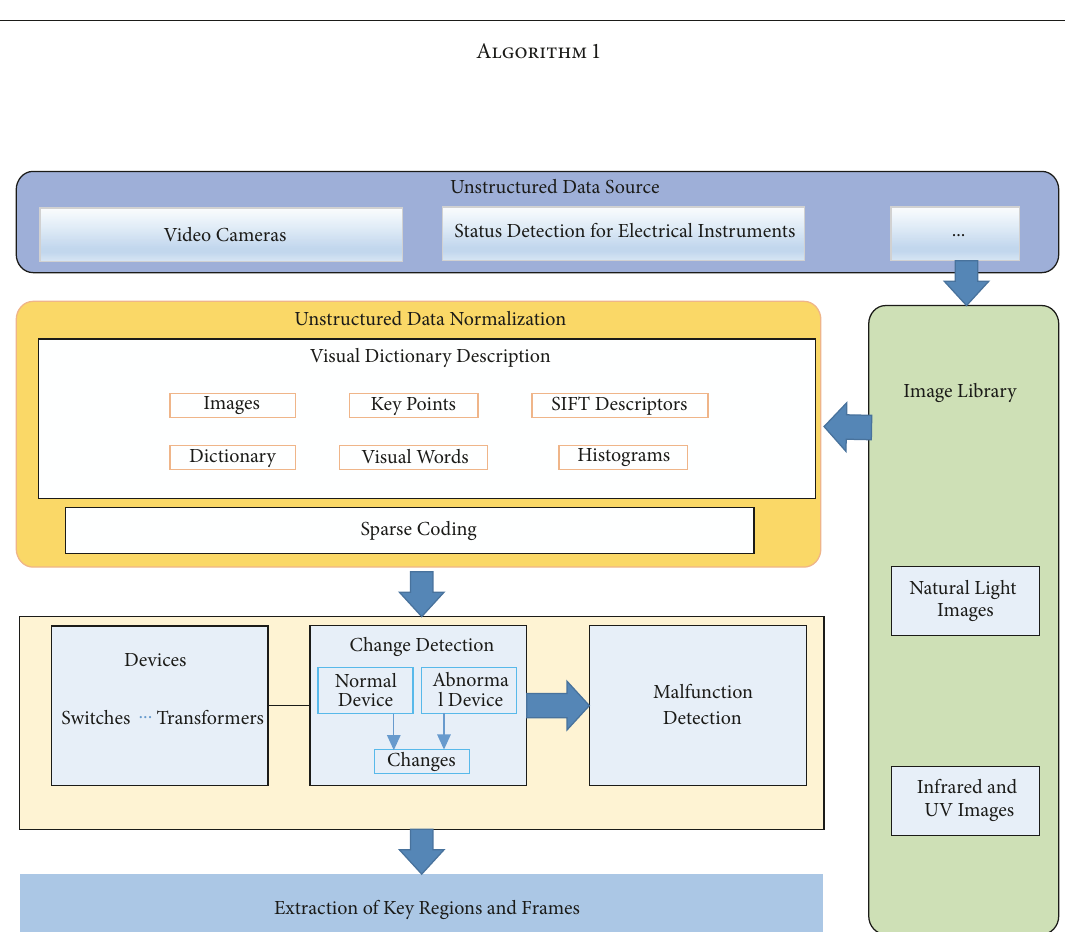
Figure 6: Transformation from nonstructural data to structural